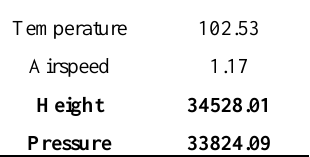
Table 10. VIF Values in Step-wise